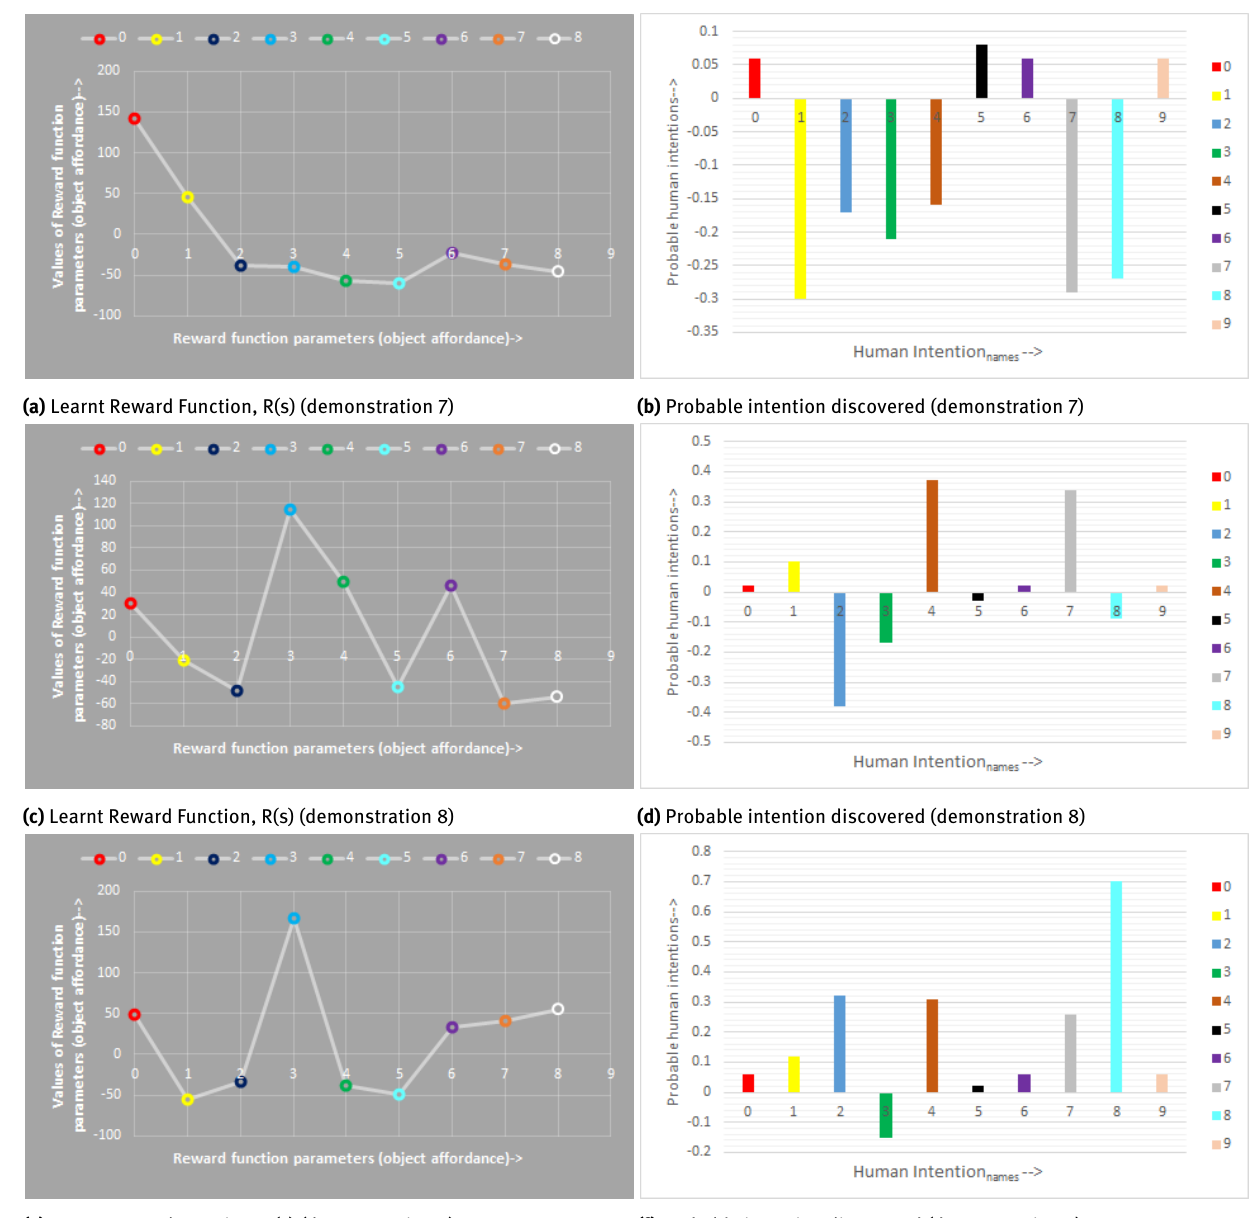
Figure 6: This figure is similar to Figure 4. It consists of three pair of graphs originated from three categories of demonstrations of CAD-120 dataset. However, these three categories are different from Figure 4 and Figure 5. In Figure 4a and Figure 4b, the meaning of the